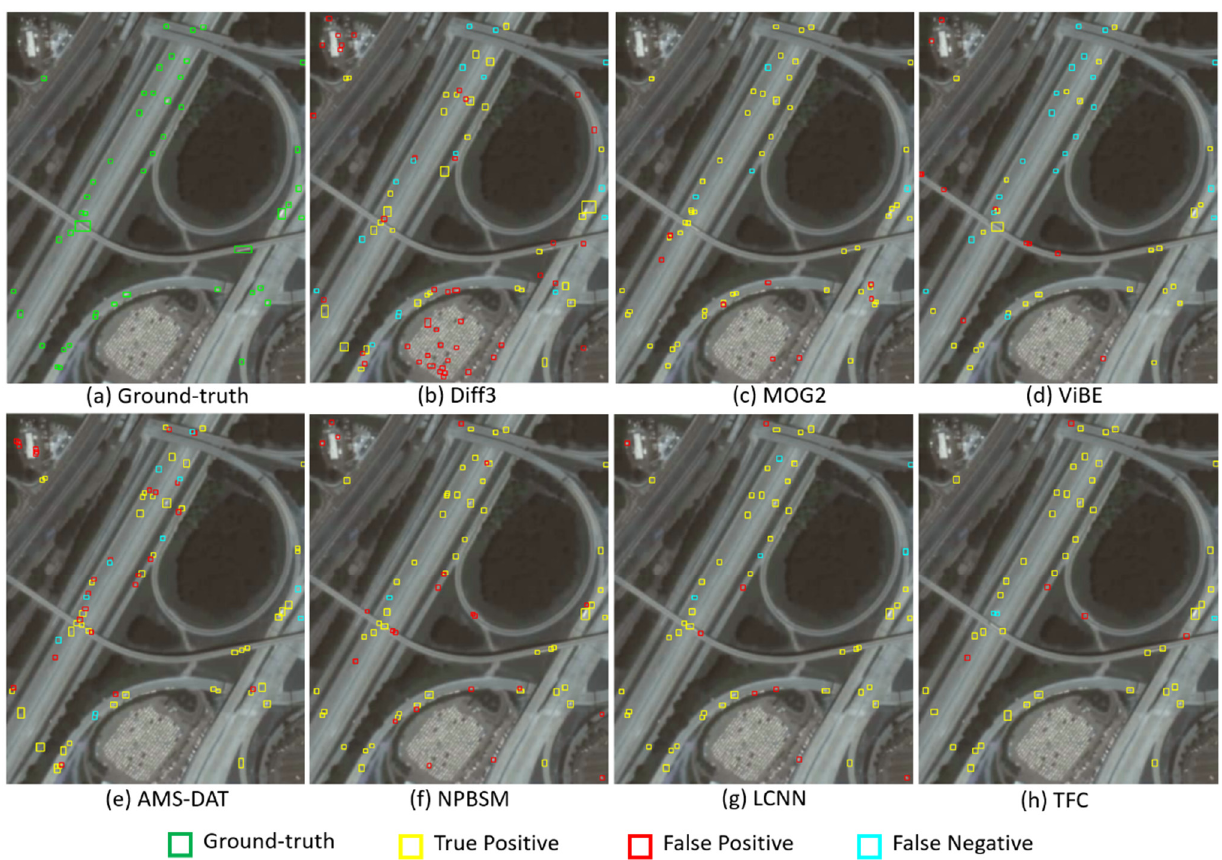
Figure 13. Detection of Dataset 2: yellow indicates correct targets, red shows false targets, and cyan depicts missed targets. Panels ( a ) Ground-truth, ( b ) Diff3, ( c ) MOG2, ( d ) ViBE, ( e ) AMS-DAT, ( f ) NPBSM, ( g ) LCNN, and ( h ) TFC (the proposed method). Table 2. Evaluation of the detection results from different methods. Data